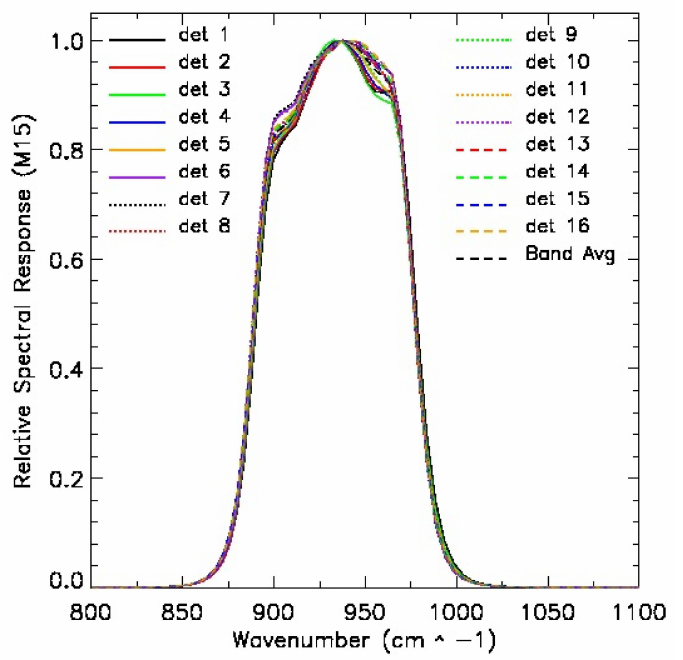
Figure 1. Detector-level and band-averaged relative spectral response (RSR) in M15. Note: M16A and M16B figures are similar, not shown